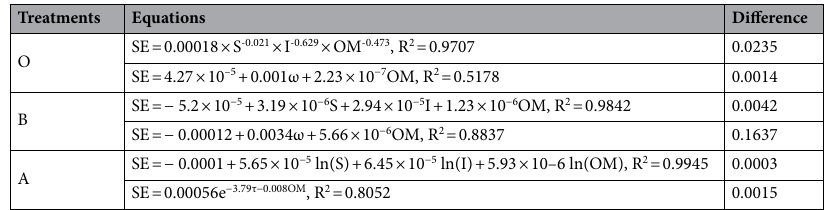
Table 7. The optimized sheet erosion equations for three slope treatments.O is bare slope, B is Prunella vulgaris combined with earthworm planting slope, A is Single planting prunella vulgaris slope.